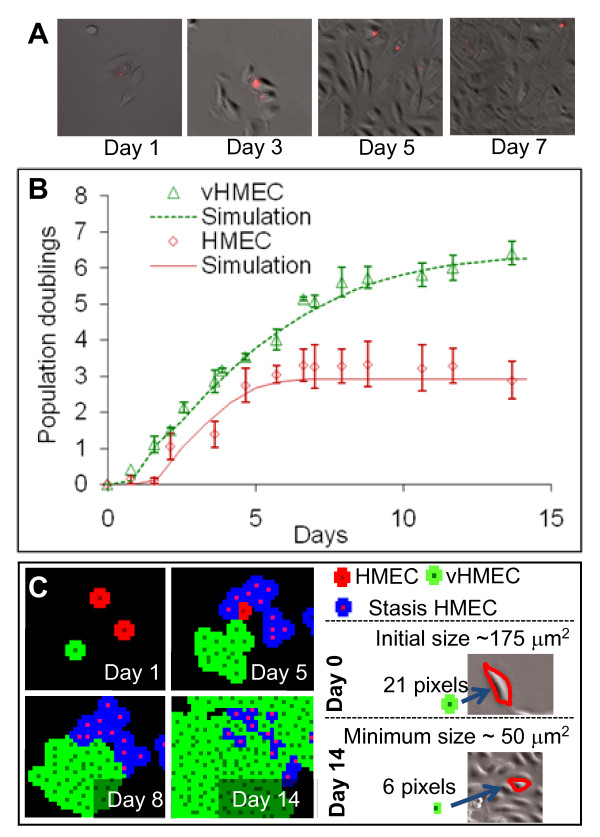
The agent-based model is validated by experimental data. (A) Growth characteristics of co-cultured human mammary epithelial cells (HMEC) (labeled with vital dye Qtracker565; Invitrogen) and variant human mammary epithelial cells (vHMEC) (unlabeled) were recorded by time-lapse microscopy. An example is presented of the changes in proportions of cells present in a field of view monitored over seven days. (B) Growth of co-cultured HMEC and vHMEC was compared with ABM simulations. Each data point represents the mean of four biological replicates. Pre-stasis HMEC (red diamonds) stopped proliferating after four days in culture in contrast to vHMEC (green triangles) that continued to proliferate until the cultures achieved confluence. Solid lines show agent-based simulations, based on the initial cell densities, cell cycle duration during the proliferative phase (26 hours for both cell types), maximum cell compression observed at full confluence, and an intrinsic limit on the number of population doublings achievable by HMEC. Note that the simulations of the model were well correlated with the experimental data, indicating that kinetic growth rates could be predicted accurately for both cell types using a limited number of assumptions. (C) Illustration of growth simulation. Normal growing HMEC (red) undergo limited divisions before losing proliferative potential and undergoing stasis (blue). vHMEC (green) are capable of unlimited of divisions in this example. At low density (Day 1), most cells occupy a maximum area (that is, 21 pixels equivalent to 175 μm2, matching light microscopy measurements). Cells continue dividing as space becomes more restricted (Day 5), until the available adjacent space reaches a minimum of six pixels (50 μm2 at Day 14). Such simulations accurately recapitulate contact inhibition as measured by time-lapse microscopy.